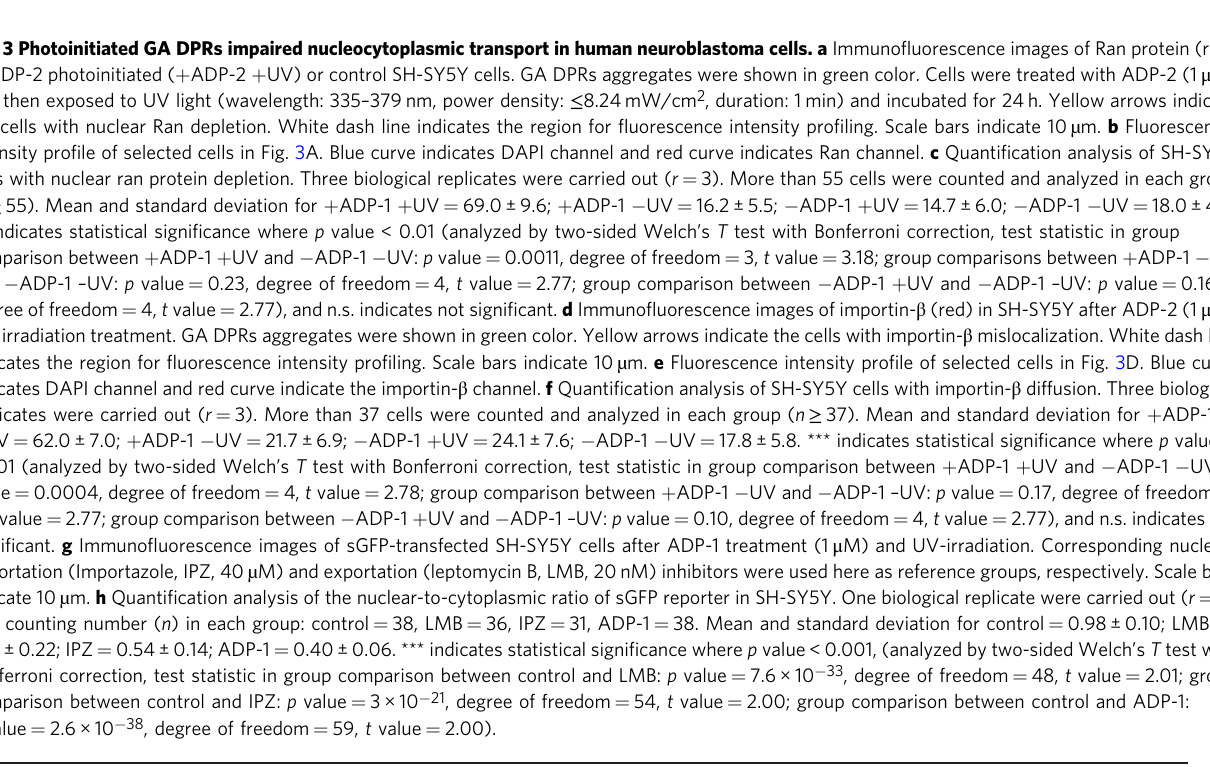
Fig. 3 Photoinitiated GA DPRs impaired nucleocytoplasmic transport in human neuroblastoma cells. a Immuno fl uorescence images of Ran protein (red) in ADP-2 photoinitiated ( + ADP-2 + UV) or control SH-SY5Y cells. GA DPRs aggregates were shown in green color. Cells were treated with ADP-2 (1 μ M) and then exposed to UV light (wavelength: 335 – 379 nm, power density: ≤ 8.24 mW/cm 2 , duration: 1 min) and incubated for 24 h. Yellow arrows indicate the cells with nuclear Ran depletion. White dash line indicates the region for fl uorescence intensity pro fi ling. Scale bars indicate 10 µ m. b Fluorescence intensity pro fi le of selected cells in Fig. 3A. Blue curve indicates DAPI channel and red curve indicates Ran channel. c Quanti fi cation analysis of SH-SY5Y cells with nuclear ran protein depletion. Three biological replicates were carried out ( r = 3). More than 55 cells were counted and analyzed in each group ( n ≥ 55). Mean and standard deviation for + ADP-1 + UV = 69.0 ± 9.6; + ADP-1 − UV = 16.2 ± 5.5; − ADP-1 + UV = 14.7 ± 6.0; − ADP-1 − UV = 18.0 ± 4.4. ** indicates statistical signi fi cance where p value < 0.01 (analyzed by two-sided Welch ’ s T test with Bonferroni correction, test statistic in group comparison between + ADP-1 + UV and − ADP-1 − UV: p value = 0.0011, degree of freedom = 3, t value = 3.18; group comparisons between + ADP-1 − UV and − ADP-1 – UV: p value = 0.23, degree of freedom = 4, t value = 2.77; group comparison between − ADP-1 + UV and − ADP-1 – UV: p value = 0.16, degree of freedom = 4, t value = 2.77), and n.s. indicates not signi fi cant. d Immuno fl uorescence images of importin- β (red) in SH-SY5Y after ADP-2 (1 μ M) and irradiation treatment. GA DPRs aggregates were shown in green color. Yellow arrows indicate the cells with importin- β mislocalization. White dash line indicates the region for fl uorescence intensity pro fi ling. Scale bars indicate 10 µ m. e Fluorescence intensity pro fi le of selected cells in Fig. 3D. Blue curve indicates DAPI channel and red curve indicate the importin- β channel. f Quanti fi cation analysis of SH-SY5Y cells with importin- β diffusion. Three biological replicates were carried out ( r = 3). More than 37 cells were counted and analyzed in each group ( n ≥ 37). Mean and standard deviation for + ADP-1 + UV = 62.0 ± 7.0; + ADP-1 − UV = 21.7 ± 6.9; − ADP-1 + UV = 24.1 ± 7.6; − ADP-1 − UV = 17.8 ± 5.8. *** indicates statistical signi fi cance where p value < 0.001 (analyzed by two-sided Welch ’ s T test with Bonferroni correction, test statistic in group comparison between + ADP-1 + UV and − ADP-1 − UV: p value = 0.0004, degree of freedom = 4, t value = 2.78; group comparison between + ADP-1 − UV and − ADP-1 – UV: p value = 0.17, degree of freedom = 4, t value = 2.77; group comparison between − ADP-1 + UV and − ADP-1 – UV: p value = 0.10, degree of freedom = 4, t value = 2.77), and n.s. indicates not signi fi cant. g Immuno fl uorescence images of sGFP-transfected SH-SY5Y cells after ADP-1 treatment (1 μ M) and UV-irradiation. Corresponding nuclear importation (Importazole, IPZ, 40 µ M) and exportation (leptomycin B, LMB, 20 nM) inhibitors were used here as reference groups, respectively. Scale bars indicate 10 µ m. h Quanti fi cation analysis of the nuclear-to-cytoplasmic ratio of sGFP reporter in SH-SY5Y. One biological replicate were carried out ( r = 1). Cell counting number ( n ) in each group: control = 38, LMB = 36, IPZ = 31, ADP-1 = 38. Mean and standard deviation for control = 0.98 ± 0.10; LMB = 2.18 ± 0.22; IPZ = 0.54 ± 0.14; ADP-1 = 0.40 ± 0.06. *** indicates statistical signi fi cance where p value < 0.001, (analyzed by two-sided Welch ’ s T test with Bonferroni correction, test statistic in group comparison between control and LMB: p value = 7.6 × 10 − 33 , degree of freedom = 48, t value = 2.01; group comparison between control and IPZ: p value = 3 × 10 − 21 , degree of freedom = 54, t value = 2.00; group comparison between control and ADP-1: p value = 2.6 × 10 − 38 , degree of freedom = 59, t value =